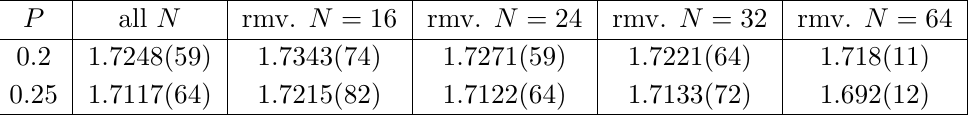
Table 3. Values of c for W con + W mix with data for different N removed. With n t = 16 .